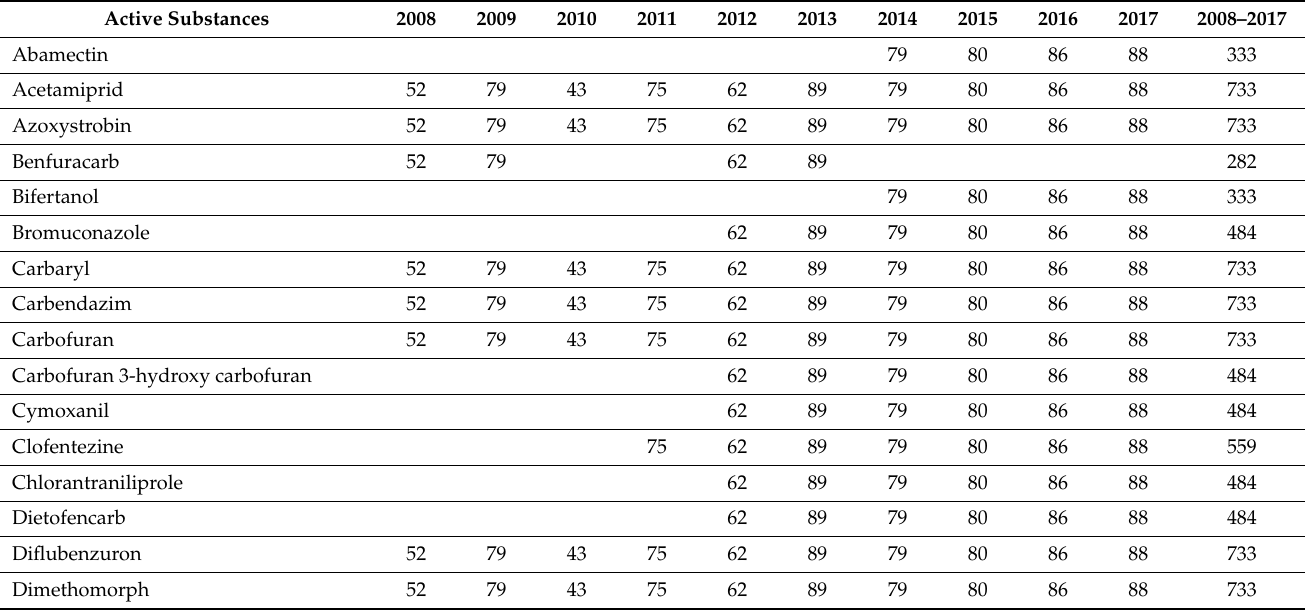
Table A1. No. samples per active substances